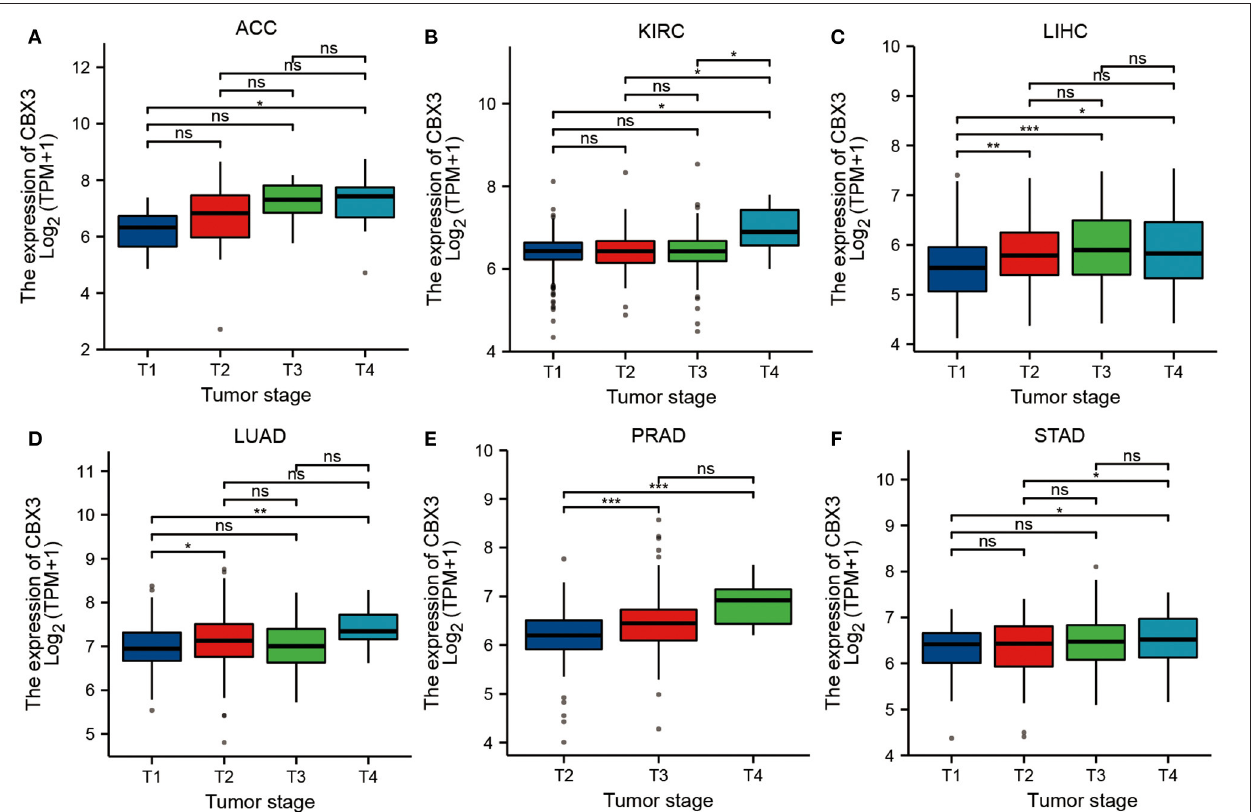
FIGURE 6 | The relationship between the expression of CBX3 and tumor stage in (A) ACC, (B) KIRC, (C) LIHC, (D) LUAD, (E) PRAD, and (F) STAD.